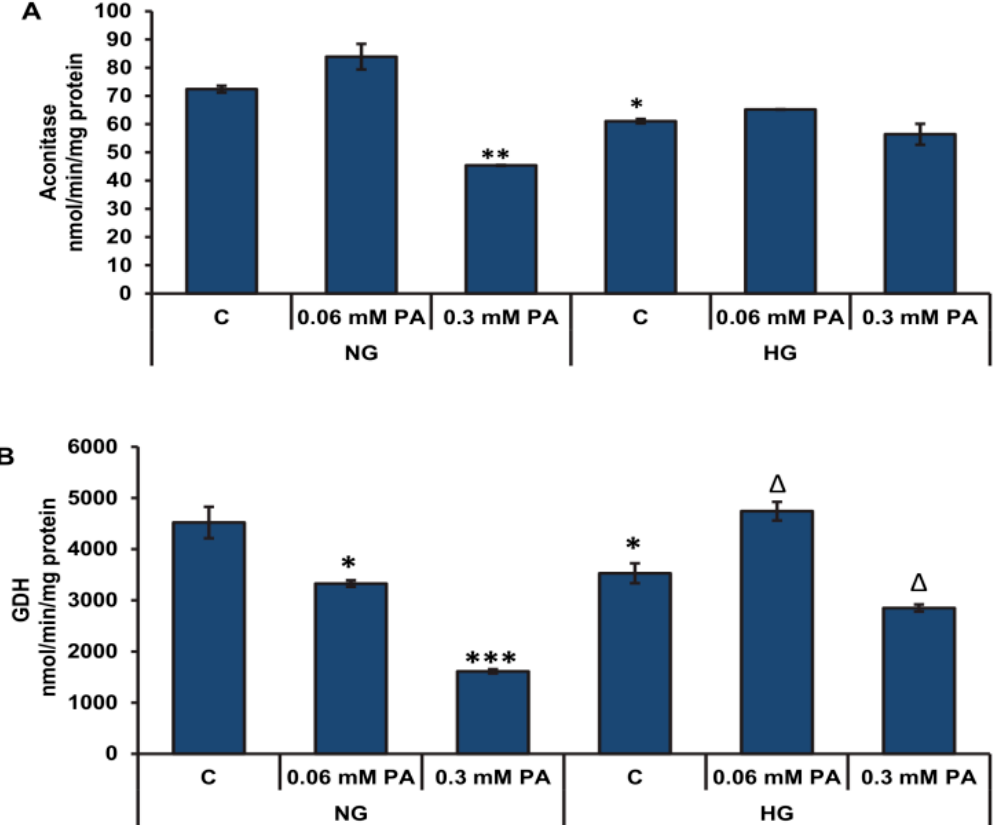
Figure 5. High glucose / high palmitic acid-induced alterations in Krebs’ cycle enzyme activities. Rin-5F cells were treated with (0.06–0.3 mM) palmitic acid under normal and high glucose conditions. Activities of ROS-sensitive enzyme, aconitase ( A ), and glutamate dehydrogenase ( B ) were measured as described previously in the Materials and Methods section. Results are expressed as mean +/ − SEM of three experiments. Asterisks indicate significant di ff erences (* p ≤ 0.05, ** p ≤ 0.01, *** p ≤ 0.001) relative to untreated control cells under normal glucose condition (NG-C), and triangles indicate significant di ff erences ( ∆ p ≤ 0.05) relative to untreated control cells under high glucose condition (HG-C).